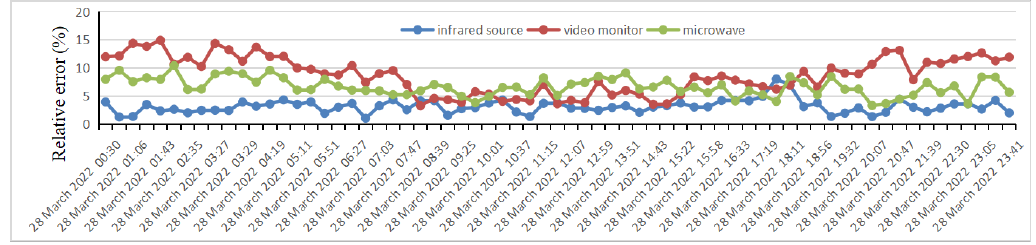
Figure 10. Relative errors of three monitoring methods in measuring amplitude.